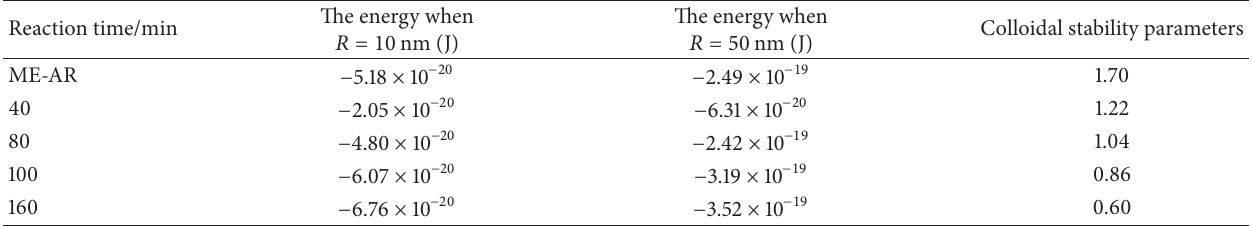
Table 7: The attractive energy between colloids of ME-AR for model